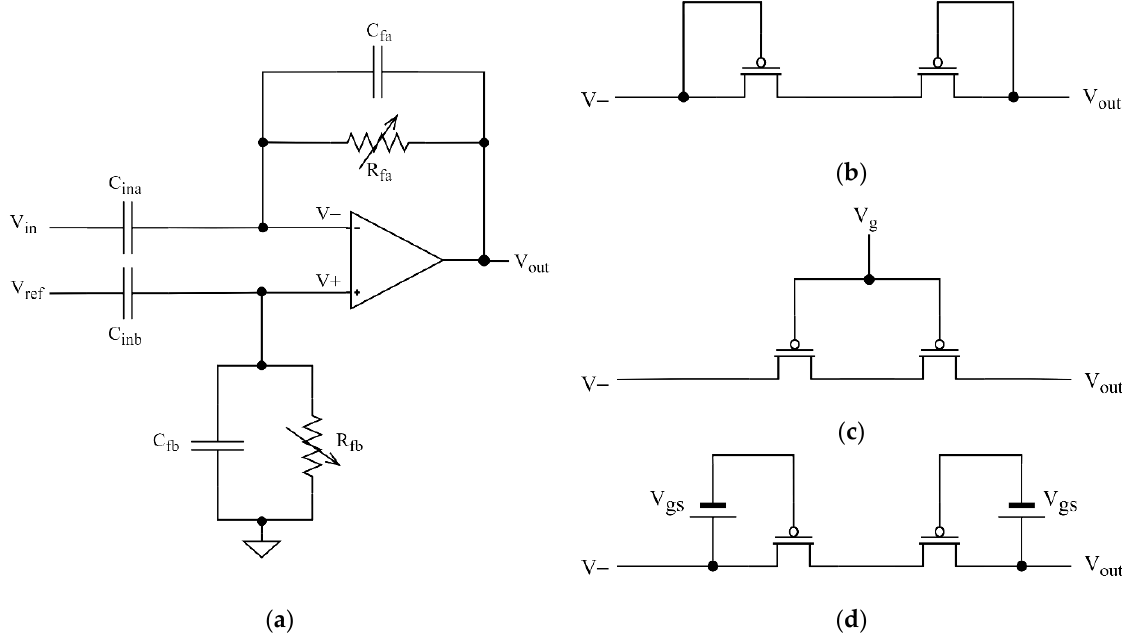
Figure 1. Architecture of an AC-coupled neural amplifier: ( a ) Schematic ( b – d ) Implementations of the pseudoresistor: ( b ) diode-connected; ( c ) subthreshold with variable V gs ; ( d ) subthreshold with fixed V gs . For the following sections we impose C ina = C inb , C fa = C fb , R fa = R fb . The distinction between the names of elements of identical values is important for some of the following analyses, where impact of individual elements on the system performance must be analyzed separately.